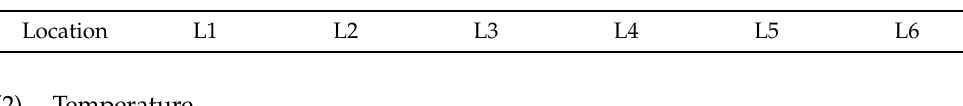
Table 3. Alarm location groups.